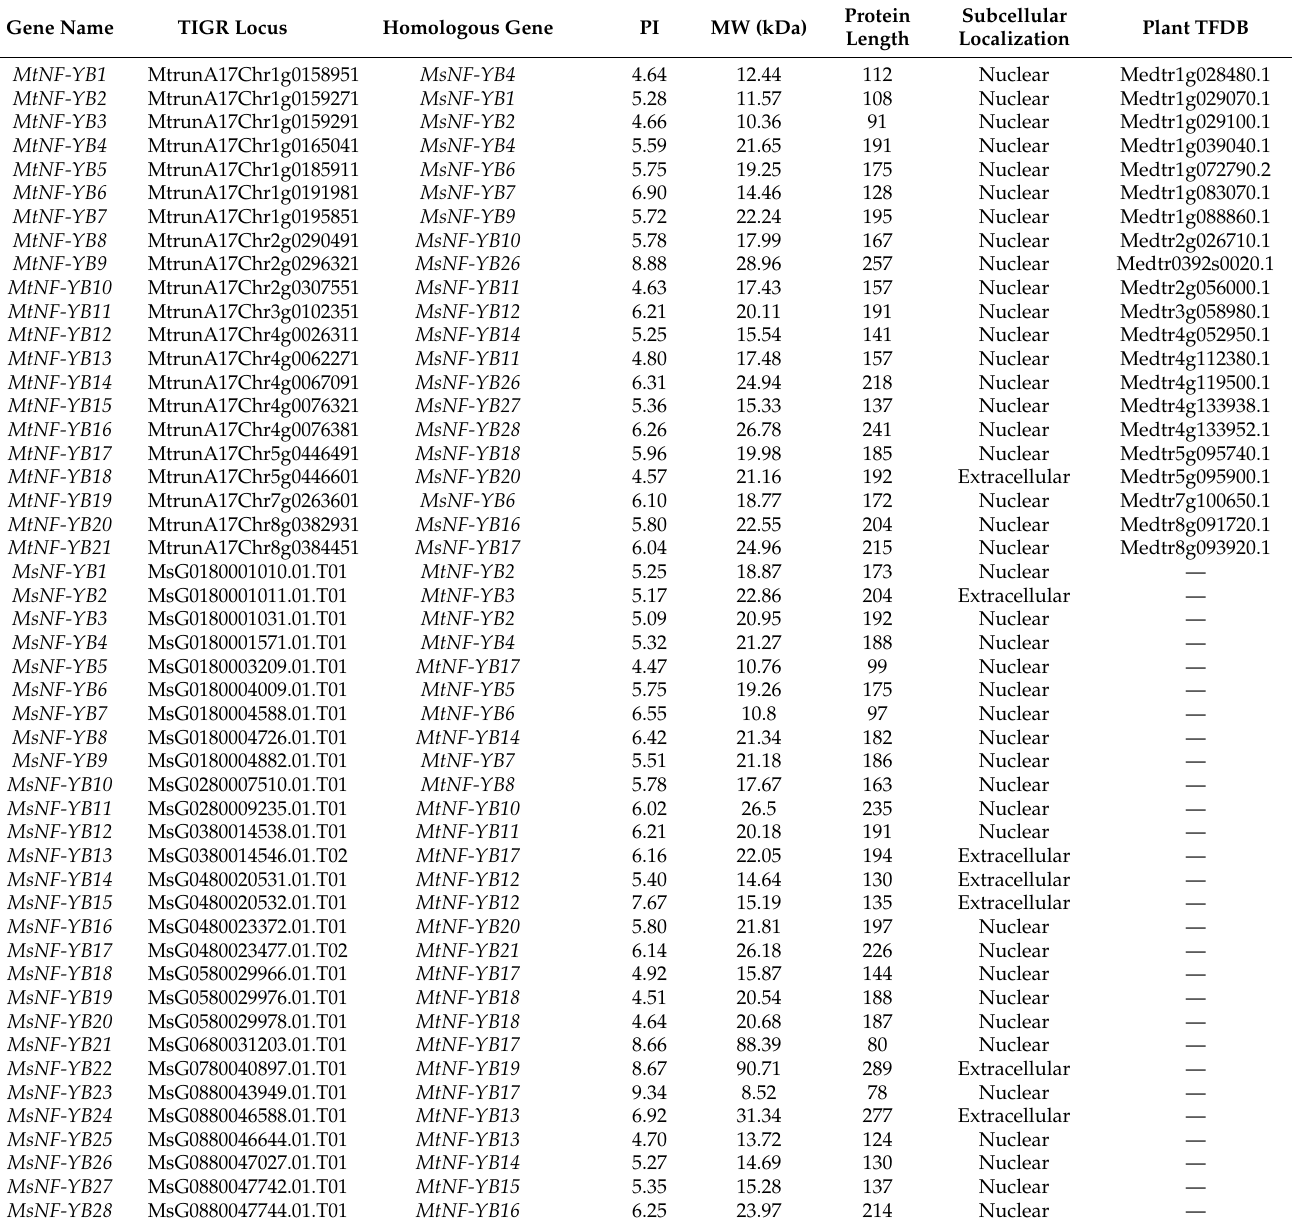
Table 1. Properties of the predicted NF-YB genes in M. truncatula and M. sativa